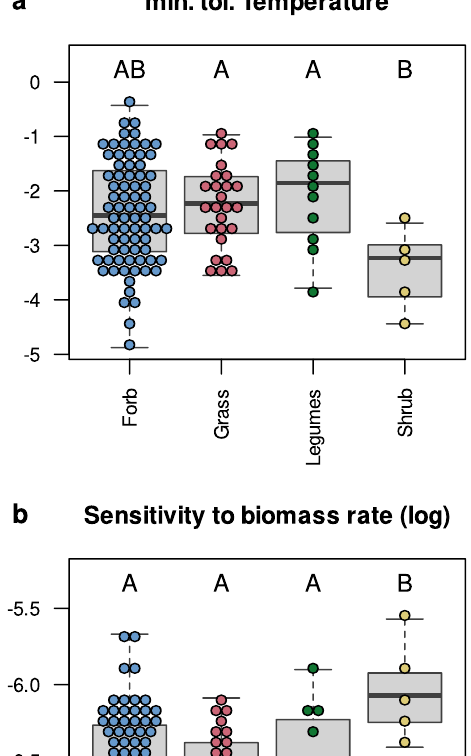
Fig. 4 Estimated demographic parameters across functional groups. Minimum tolerated temperature ( a ), sensitivity to biomass rate ( b ) and intraspeci fi c competition rate ( c ) were estimated from the median of the posterior distribution of the parameters. Functional groups were forbs (76 species), grasses (26 species), legumes (11 species) and shrubs (5 species). Boxplots indicate the median, fi rst and third quartiles of each distribution. Whiskers represent the minimum and maximum values that remain inferior 1.5 times the interquartile range below or above the distribution median. Anova tests indicate that all three demographic parameters were signi fi cantly different among functional groups ( θ min : F